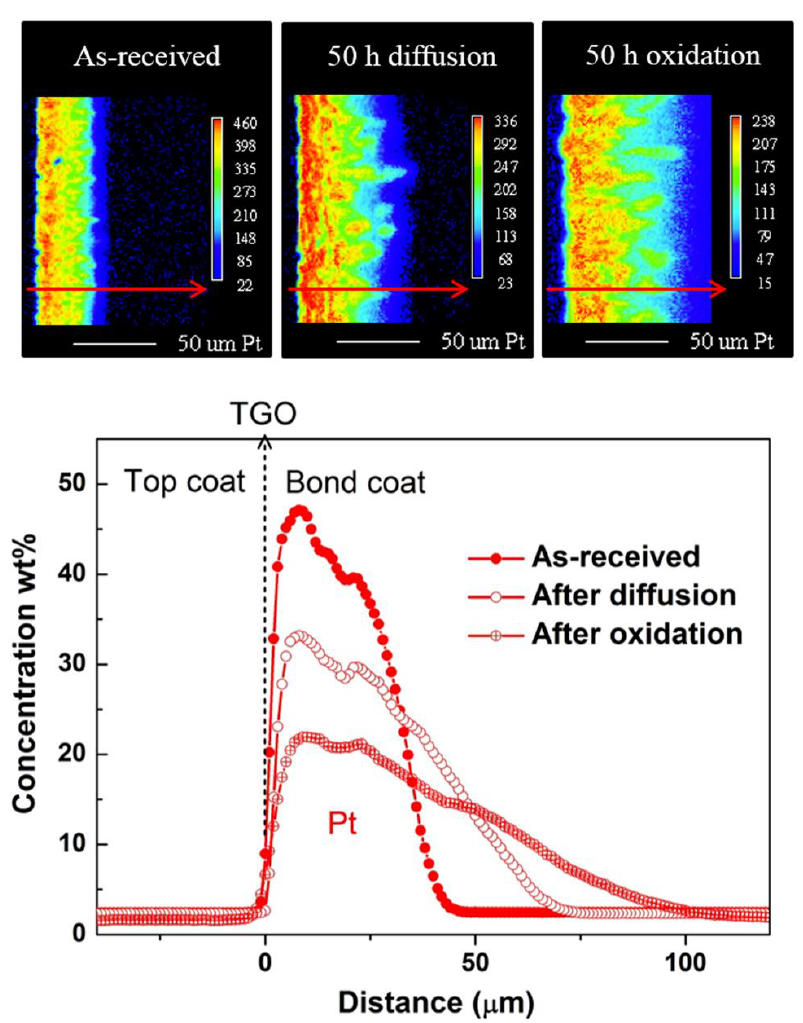
Figure 3. EPMA mappings and concentration profiles of Pt on the cross-sections of the standard Pt-diffused γ/γ’ bond coat normal to the TGO/bond coat interface.